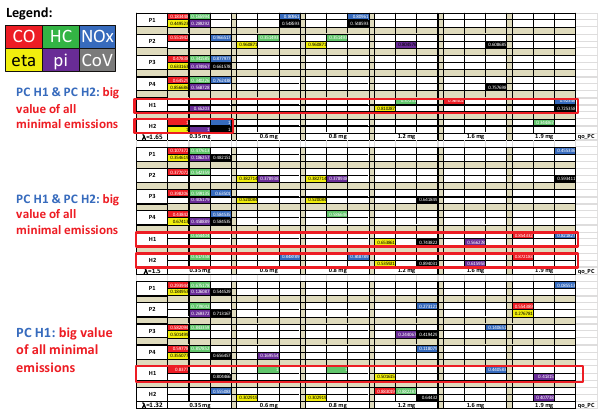
Fig. 21. Selection of the best combustion system configuration for dif- ferent impact factors assigned to different coefficients (3 rd approach) Following conclusions were reached from the 3 rd